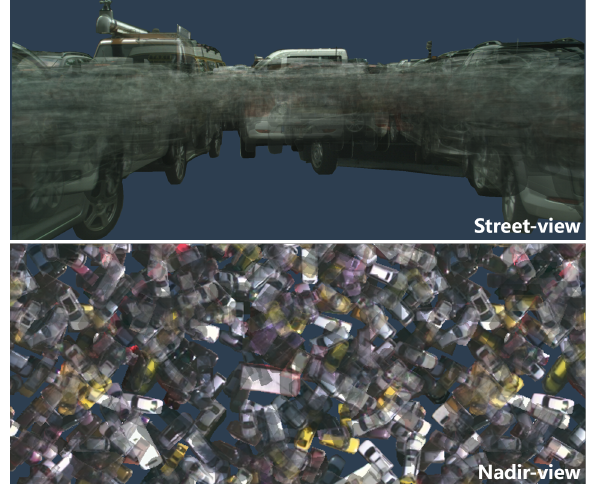
Figure 1. Illustration of different distributions of the same object (taking vehicle as an example) in street-view (top) and nadir-view (bottom) images. It can be seen that in overhead images there are more long-range relations (see appearance similarities among white cars). [Statistics based on Cityscapes and ISPRS Vaihingen